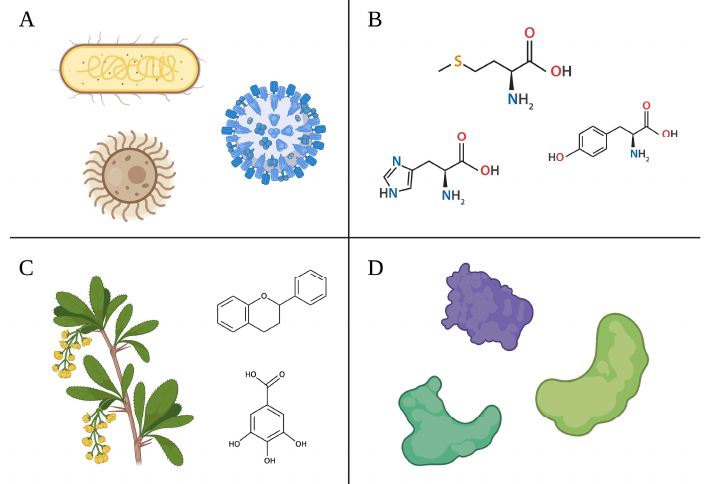
Figure 3. Common biological sources for synthesizing AgNPs: ( A ) microorganisms, ( B ) amino. acids, ( C ) plant extracts and phytochemicals, and ( D ) proteins.